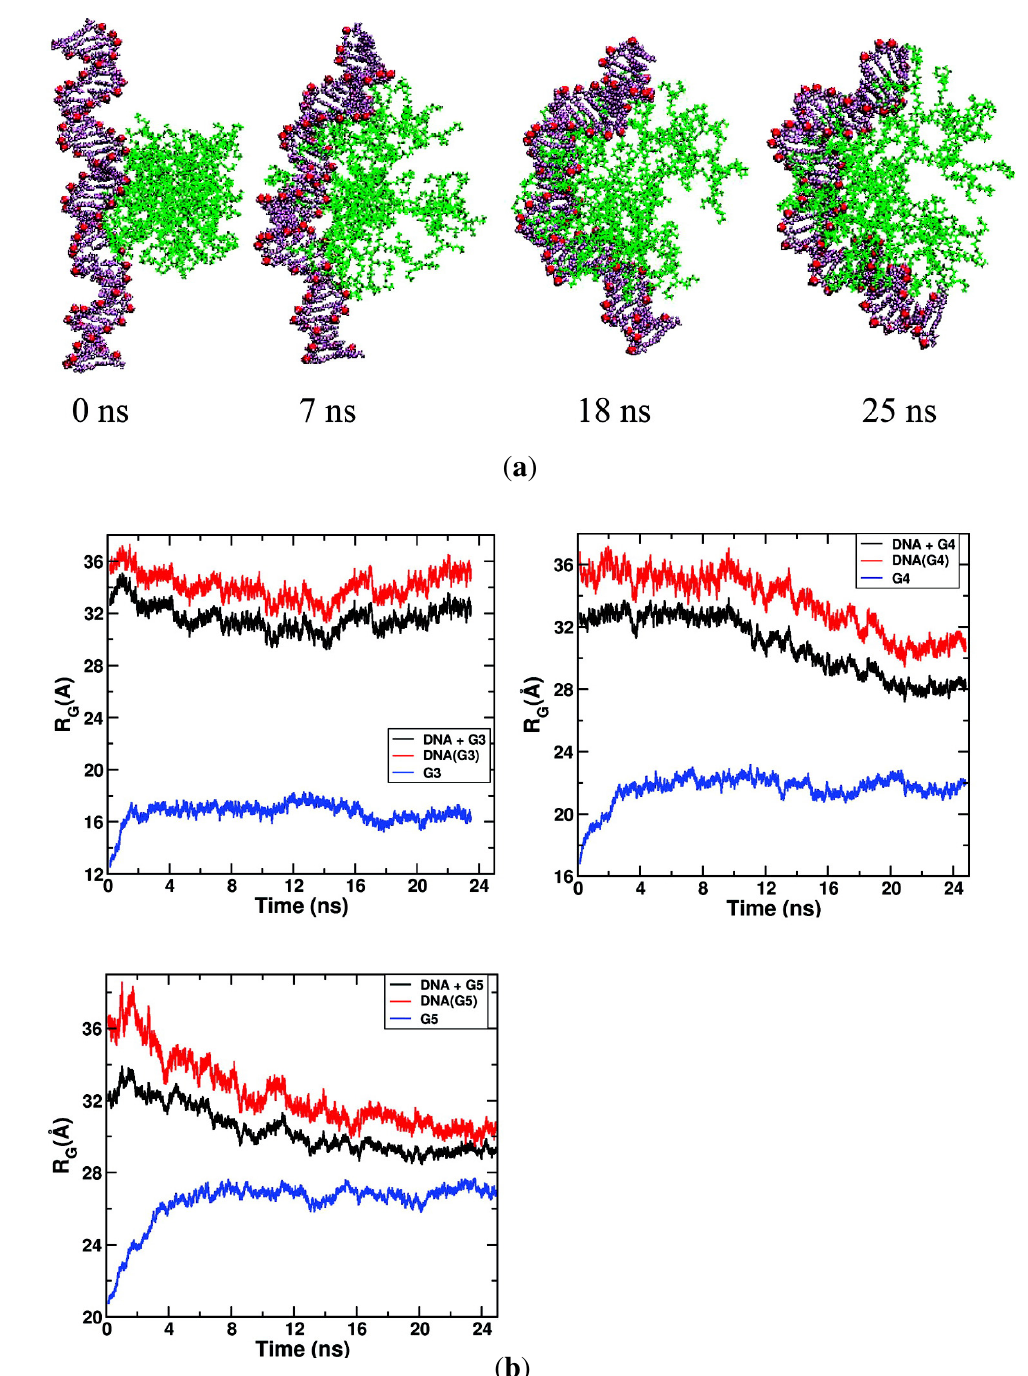
calculated by umbrella sampling and used to derive a mesoscopic stochastic model based on a Monte Carlo method. From the model they calculated the mesoscale force-extension curves. Figure 4. ( a ) Structure of the DNA-G5 dendrimer complex during various stages of complex formation at the interval of a few nanoseconds ( b ) Time evolution of the radius of gyration ( R ) of DNA, the dendrimer, and the complex for the complexation with G3, G4 and G5 G dendrimers at neutral pH. Reprinted with permission from [38]. Copyright 2011 American Chemical